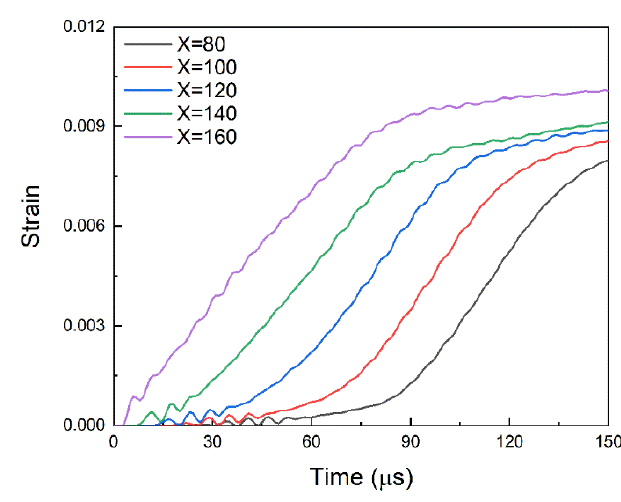
Figure 22. Strain history of FRP under the slip rate of 10 m/s.